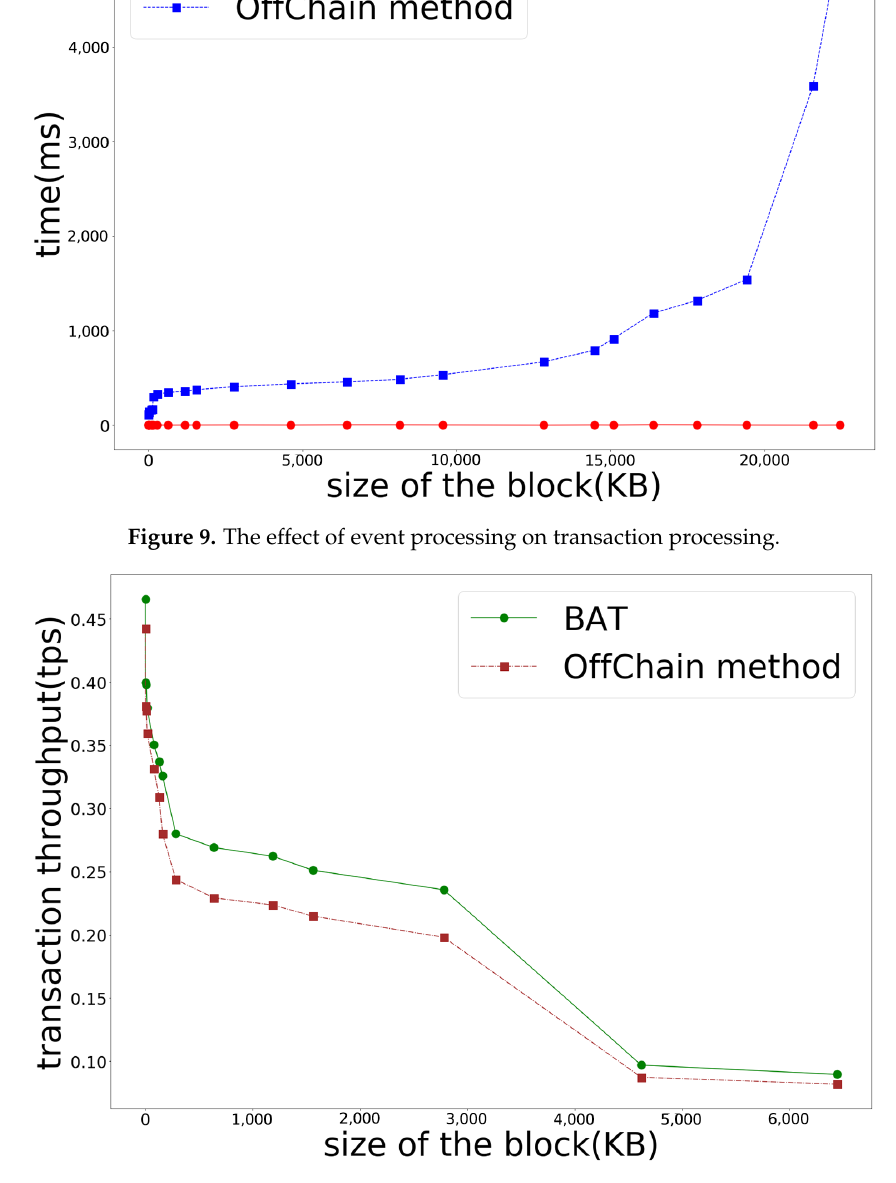
Figure 10. Throughput of